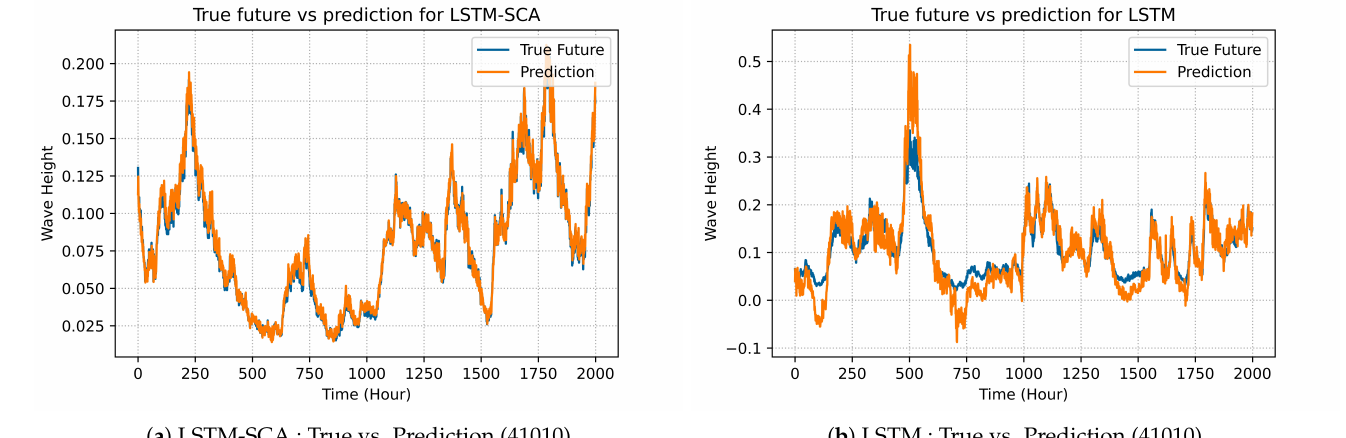
Figure 4. Comparison of LSTM models on dataset